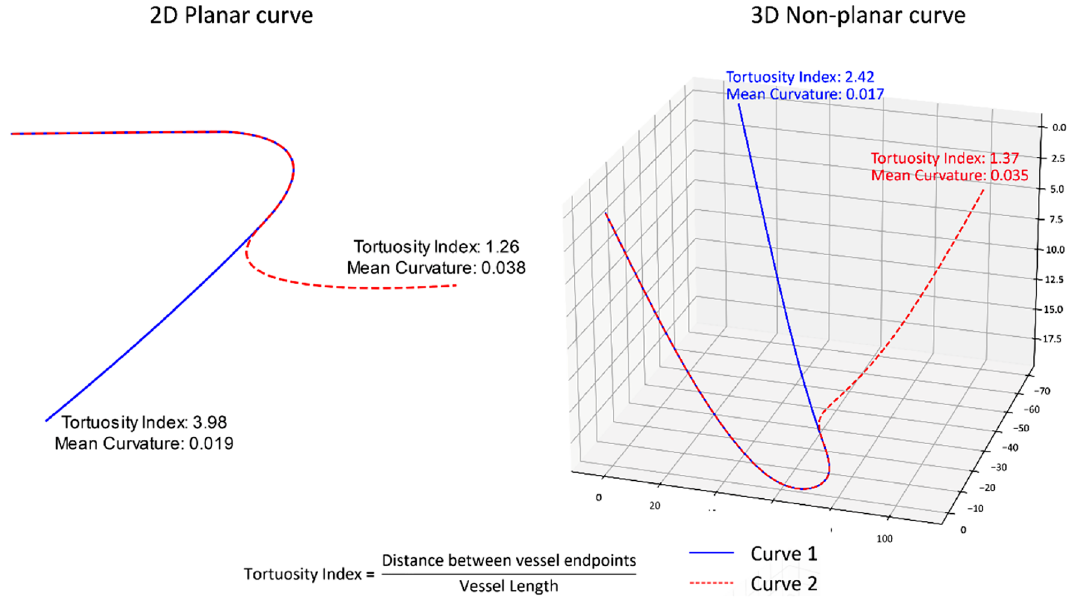
Figure 1. The behavior of mean curvature is more consistent and intuitive than the tortuosity index, in both 2- and 3-dimensional cases (left to right). Among the two lines shown, the one with an extra curved segment (red) has a greater mean curvature, but a significantly lower value of tortuosity index compared to the line with only a single bend (blue). This highlights an inherent issue with metrics such as tortuosity index, which do not consider the entire geometry.